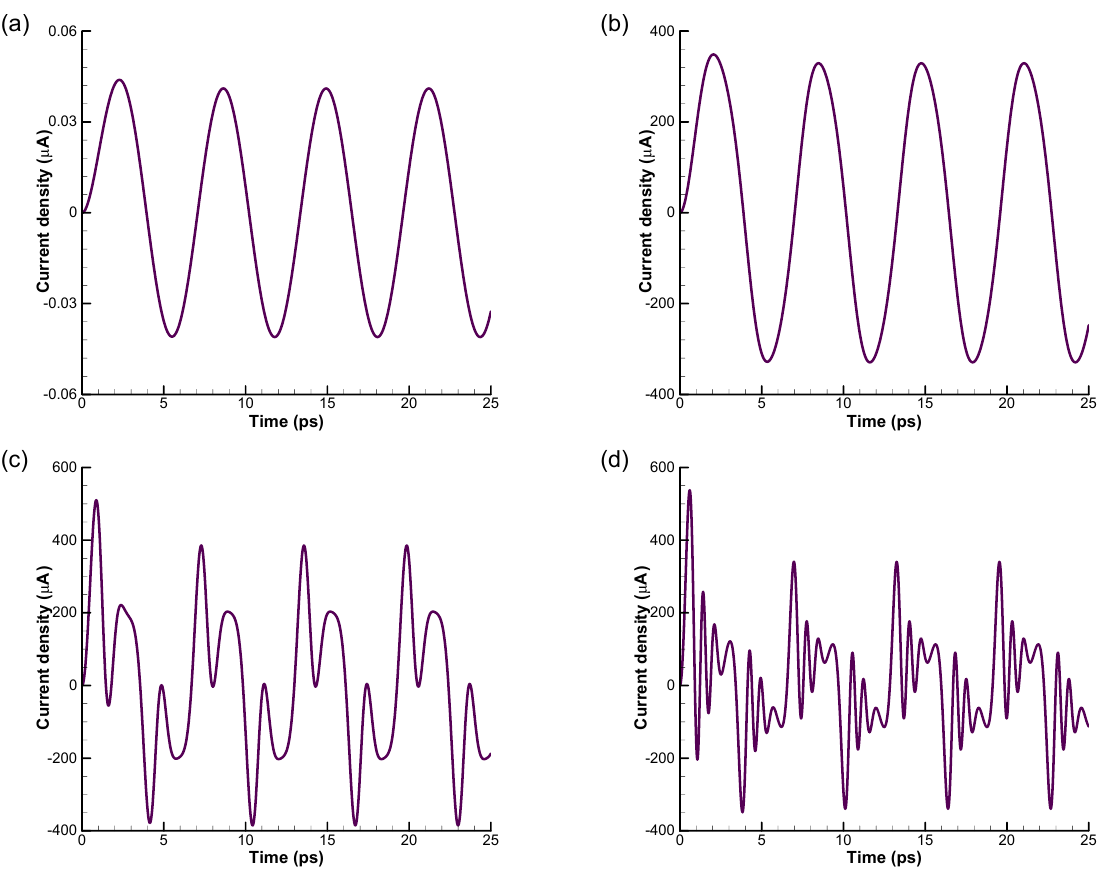
Figure 5. Effect of electric field on the time-dependent current density at ( a ) E 0 = 1 V/cm, ( b ) E 0 = 10 4 V/cm, ( c ) E 0 = 5 × 10 4 V/cm, and ( d ) E 0 = 10 5 V/cm with τ = 1.0, β = 50, µ = 0, and ω =